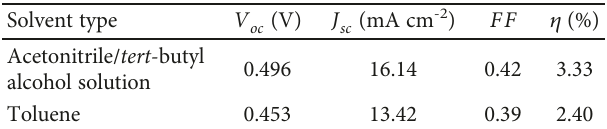
Table 1: I - V characteristics of DSSCs sensitized with MK-2 dissolved in di ff erent solvents.